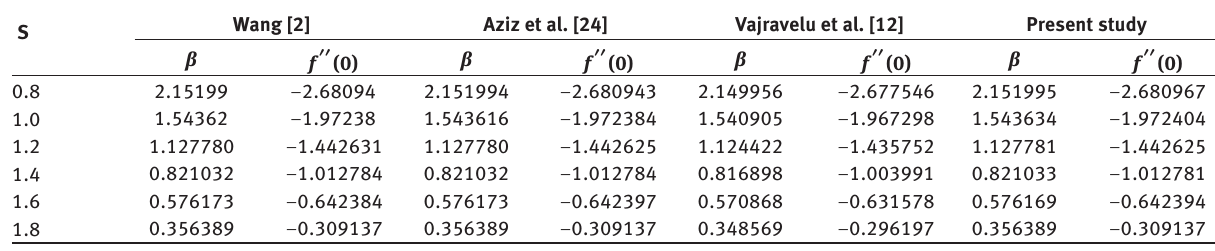
Table 1: Variation of the dimensionless film thickness and the skin friction with unsteady parameter n = 1 when M = M 1 = Nr = Q = Ec = ϵ = 0 and Pr = 1.0